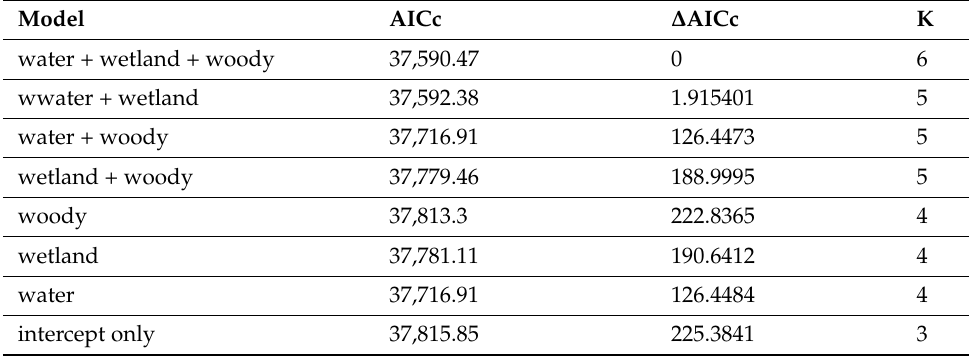
Figure 2. Selection coefficients of the ( a ) second-order and ( b ) third-order habitat selection by American white pelicans.at the breeding (open triangle) and non-breeding (open circle) ground of American white pelicans. Vertical lines are 95% confidence (panel a) and credible (panel b) intervals. Table 1. Model selection of Gaussian Markov Random Field (GMRF) models for fine-scale habitat selection by American white pelicans at the non-breeding ground in the Northern Gulf of Mexico. Symbols AICc and ∆ AICc stands for Akaike information criterion corrected for small sample size and different in AICc between a model and the best model, respectively. Letter K denotes the number of unknown